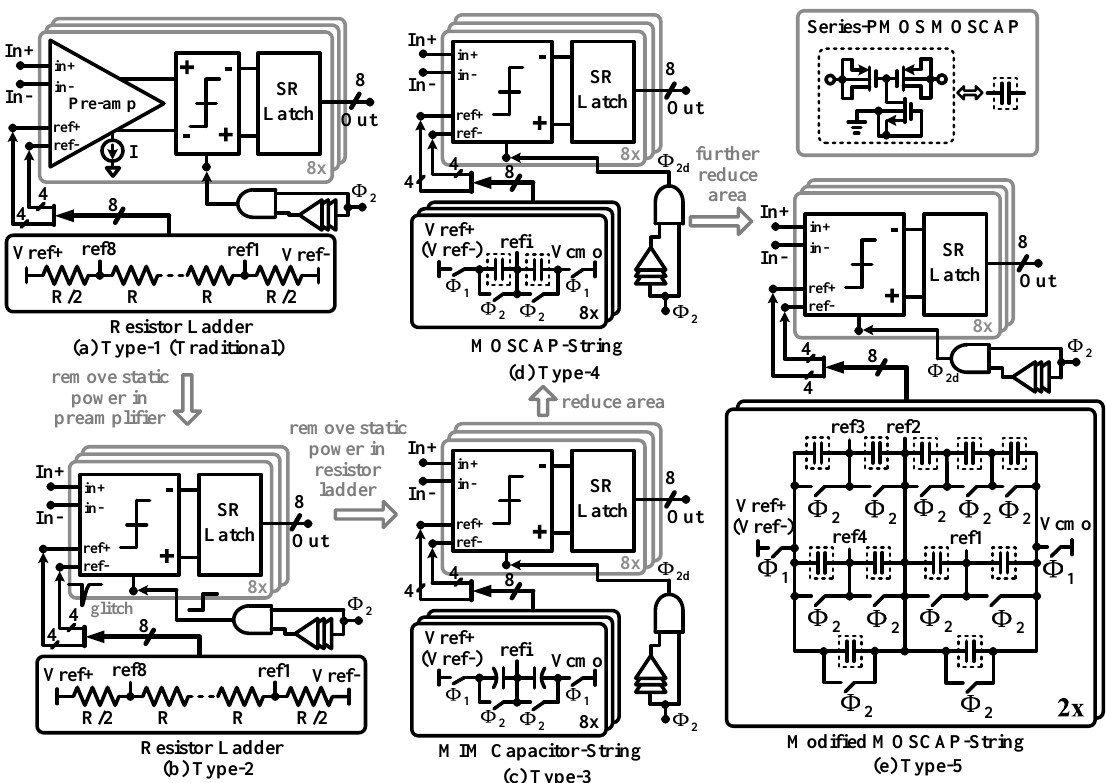
Figure 11. Circuit schematics of five nine-level quantizer structures. ( a ) Type 1: one resistor ladder and eight comparators with pre-amps; ( b ) Type 2: one resistor ladder and eight comparators without pre-amps; ( c ) Type 3: eight metal-insulator-metal (MIM) capacitor strings and eight comparators without pre-amps. ( d ) Type 4: eight MOS capacitor strings and eight comparators without pre-amps. ( e ) Type 5: two MOS capacitor strings and eight comparators without pre-amps.